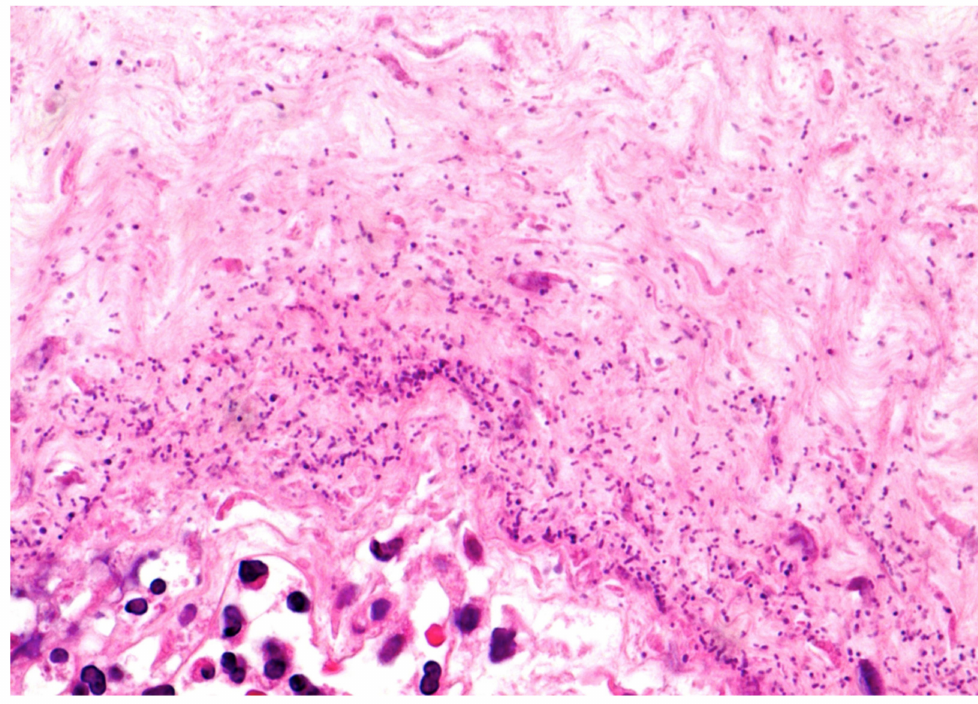
Figure 3. Chorion: Abundant coccoid bacteria within the chorionic stroma (HE staining 40 × ).